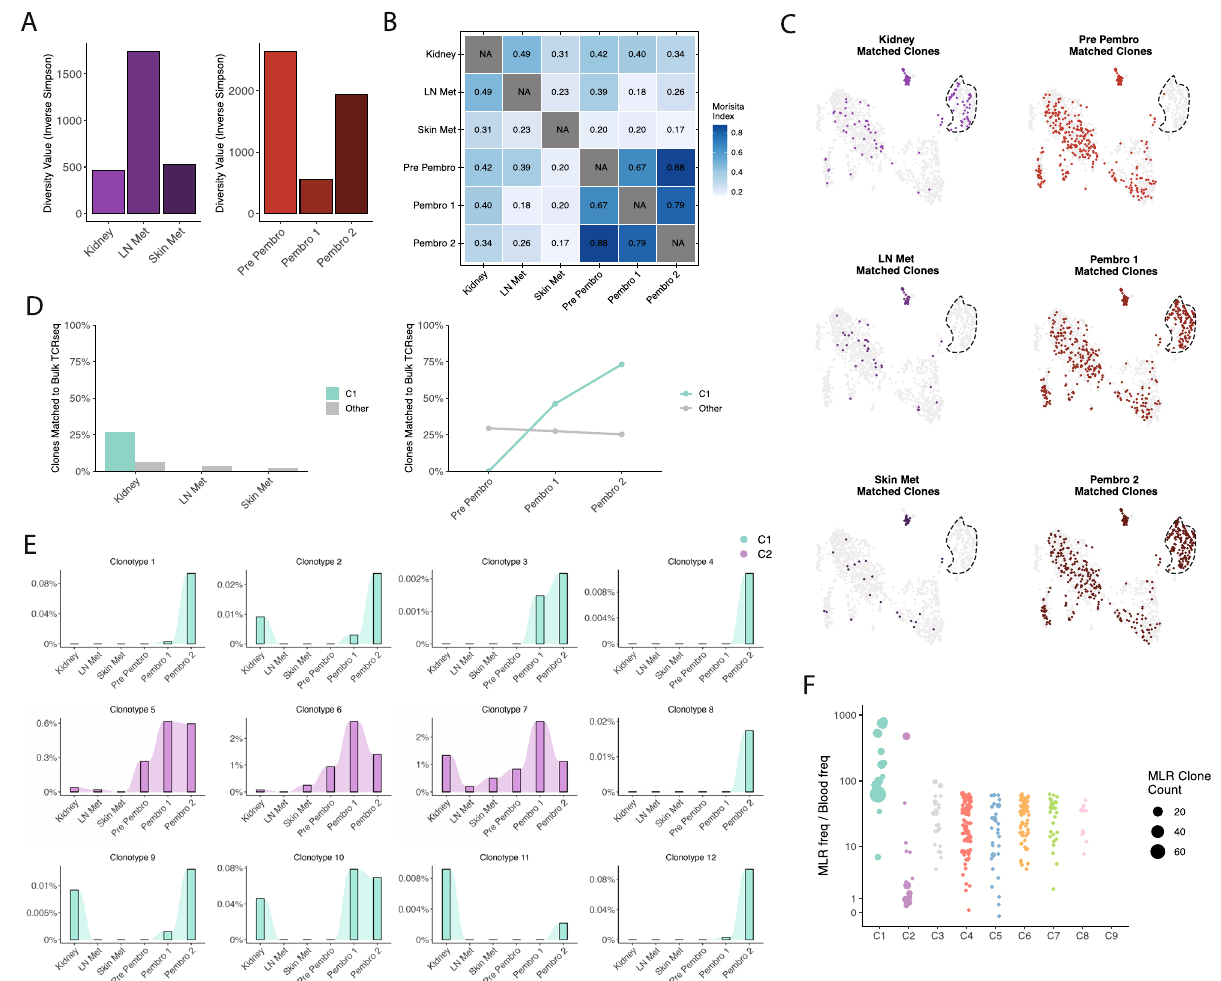
Fig.3|Trackingalloreactiveclonesacrosstissueandblood.A BarplotofInverse Simpson diversity index for tissue (left) and blood (right) bulk TCR sequencing samples. B HeatmapofclonalsharingbyMorisitaoverlapindexbetweenbulkTCR sequencing samples. C UMAPvisualization ofMLRT cells colored by whether they werefoundinindicatedbulkTCRdataset.Adashedborderisdrawnaroundcluster C1. D Percentage of C1 clones that match a clone in indicated bulk TCR dataset of